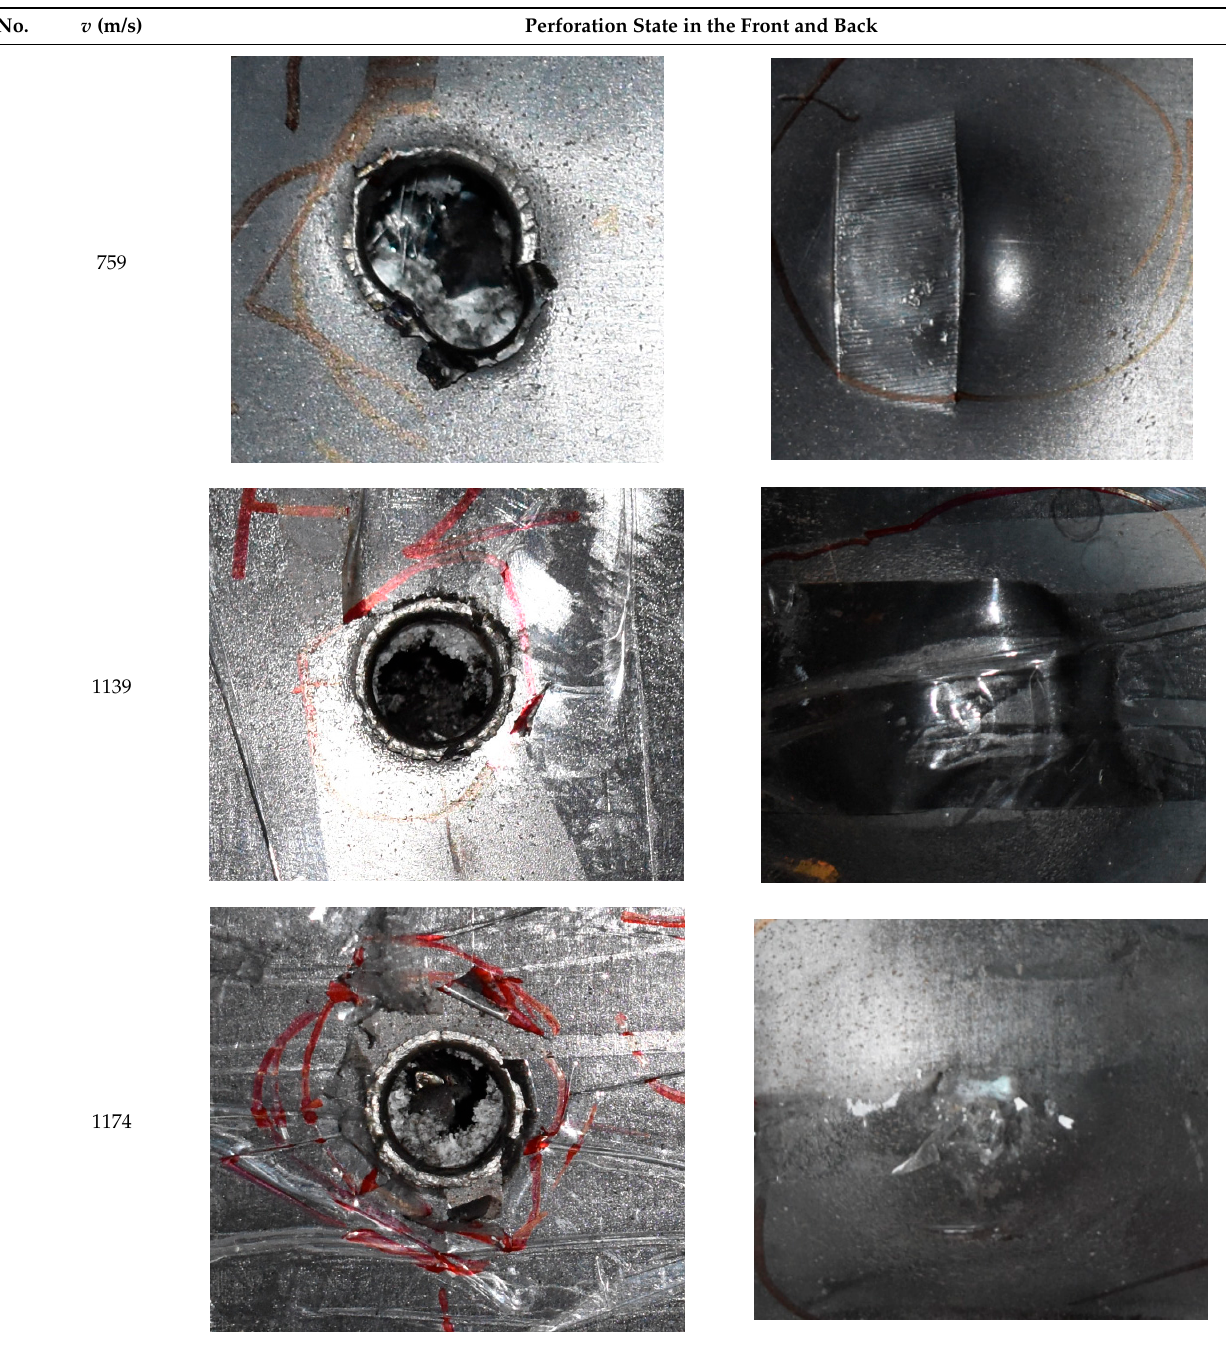
Table 9. Ballistic impact results of armor with two layers of PE.